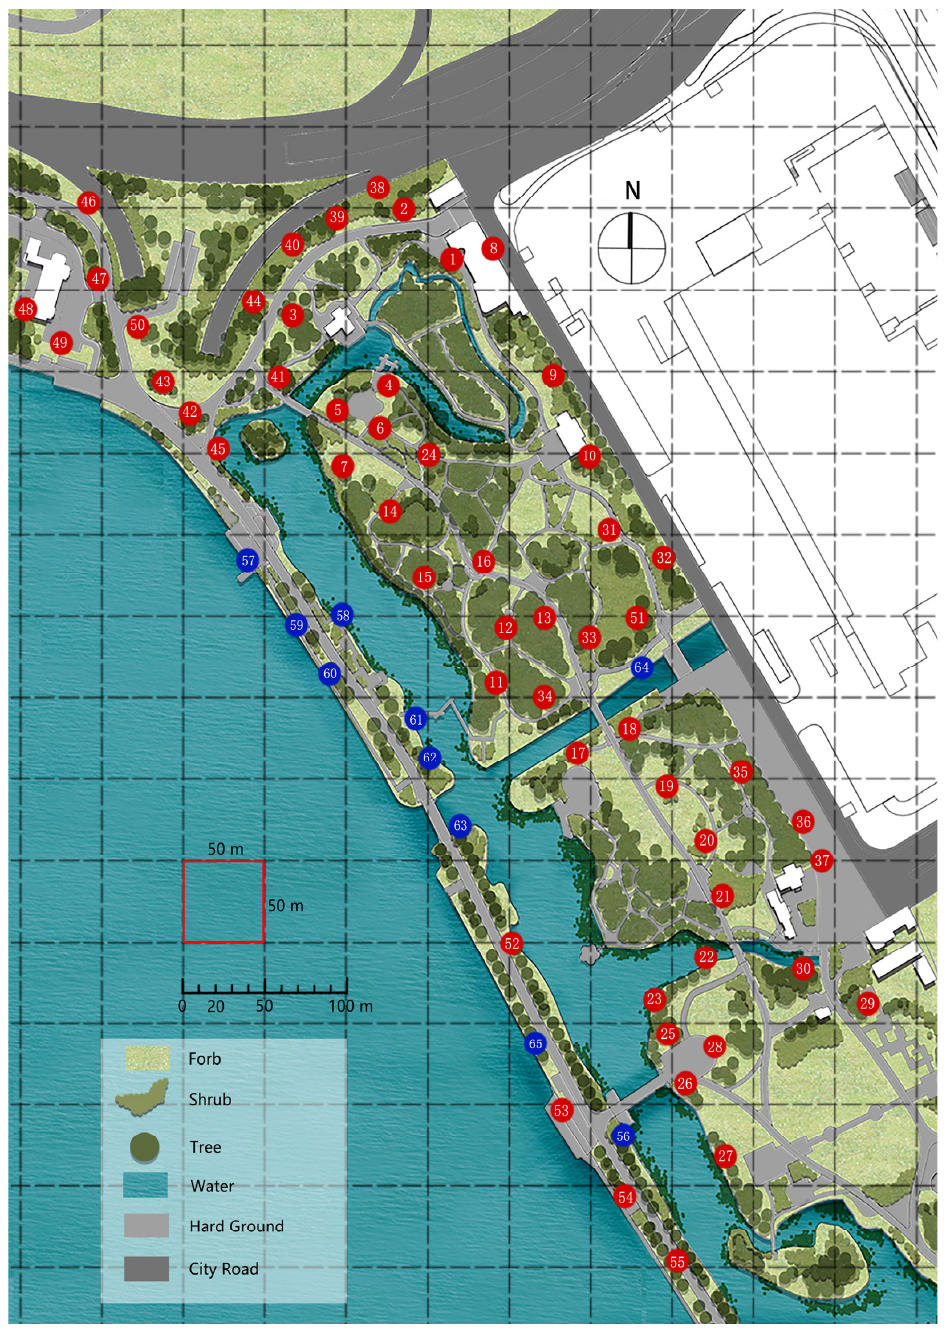
Figure 1. The study region and the site distribution of the CO 2 -baited lamps at Xuanwu Lake Park, Nanjing, China. Here, the red and blue points with numbers are the placement locations of lamps. The circle with a 5-m radius from an arbitrary blue point as the center included a certain